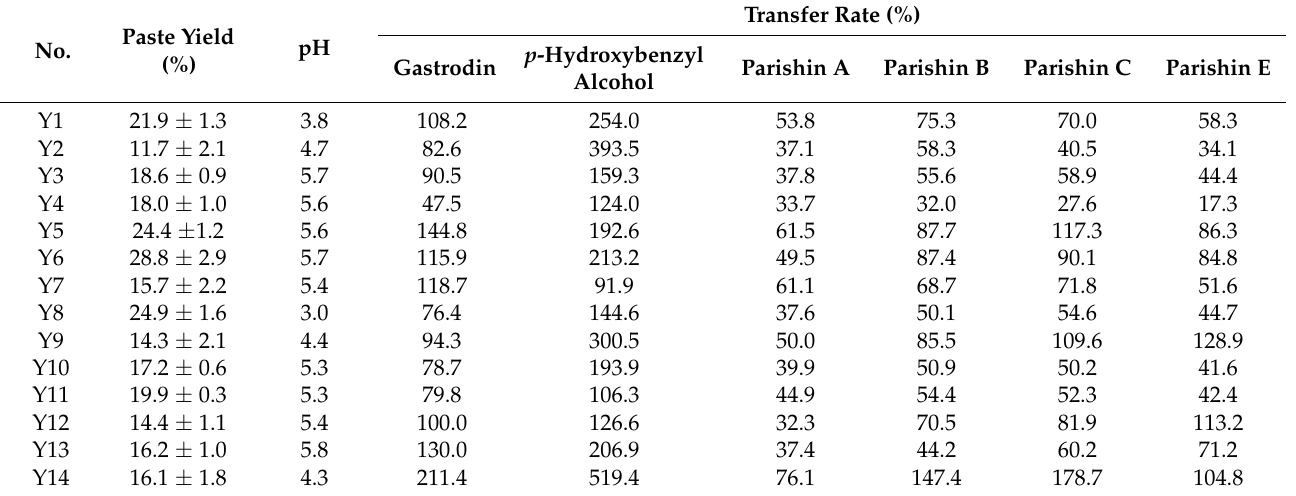
Table 3. The extraction rate of GR standard decoction (No. Y1–Y14) and transfer rate of six index components ( n = 3).